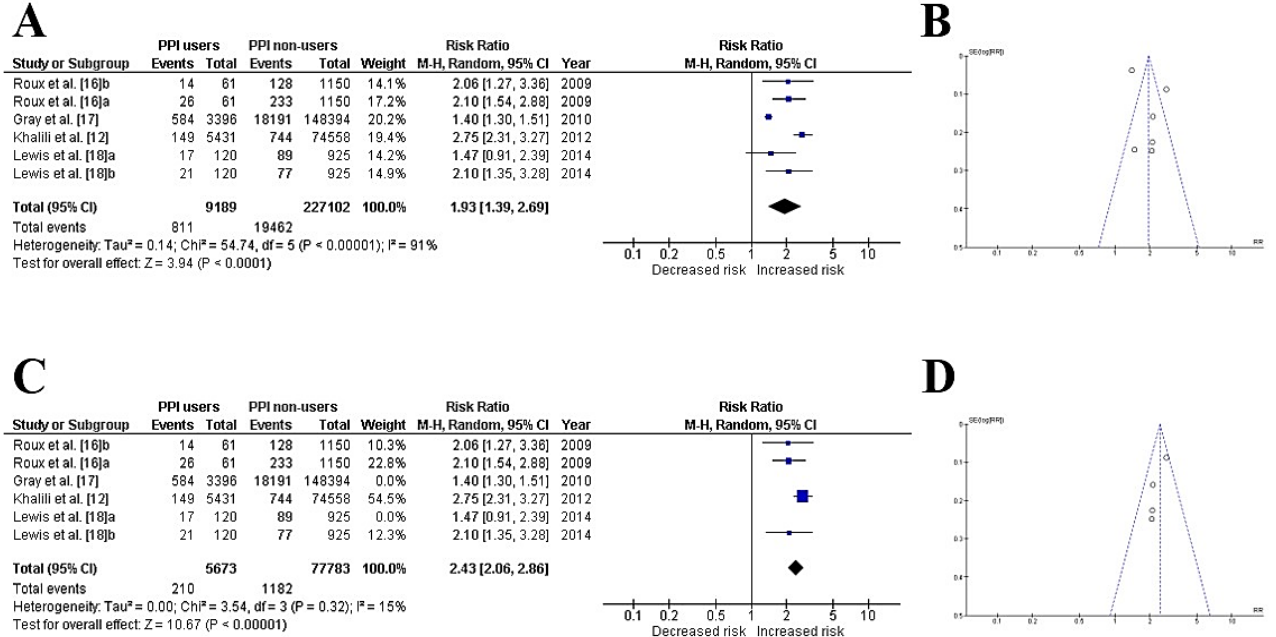
Figure 2. Forest plot for the standardized total of events among PPI users and non-users ( A ) crude forest and ( B ) funnel plots from all included studies; ( C ) forest and ( D ) funnel plots after trimming for heterogeneity and asymmetry.